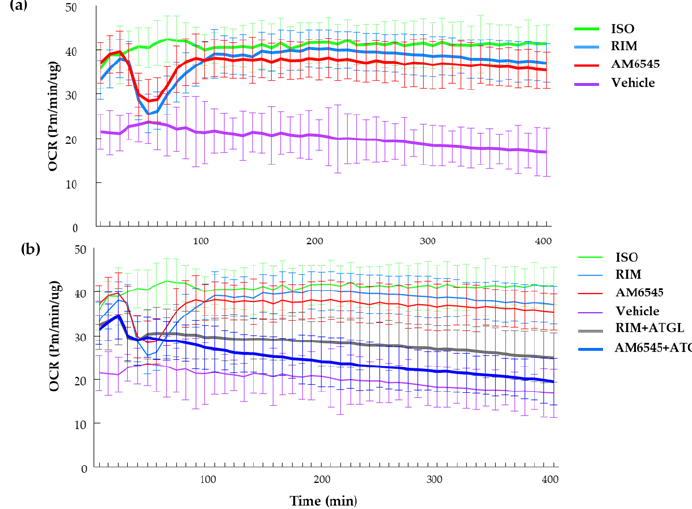
Figure 6. Real-time oxygen consumption rate (OCR) and effect of lipolysis. ( a ) Time course after differentiated 3T3-L1 treated with AM6545, rimonabant (RIM), isoproterenol (ISO), and vehicle. ( b ) Time course of treatments including the use of Atglinstatin with AM6545 and RIM. Data on graphs are presented as mean ± SEM of 4 independent rounds of the cells.